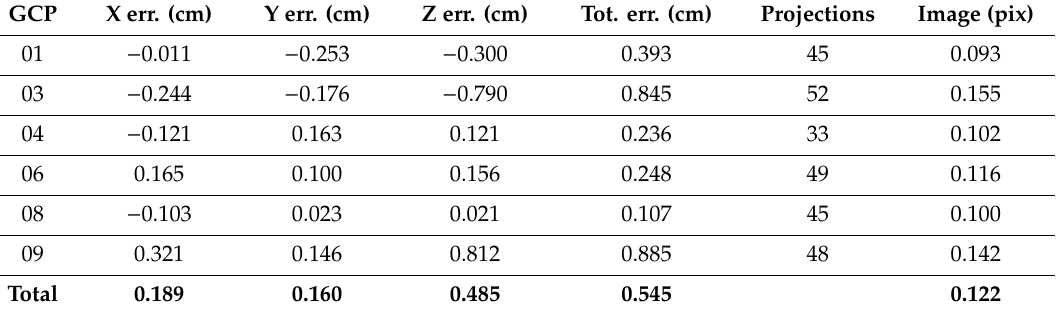
Table 3. GCP errors in the vertical-only acquisition (A).